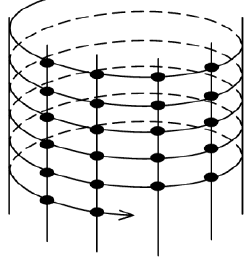
Figure 3. Spiral grid of a cylindrical image